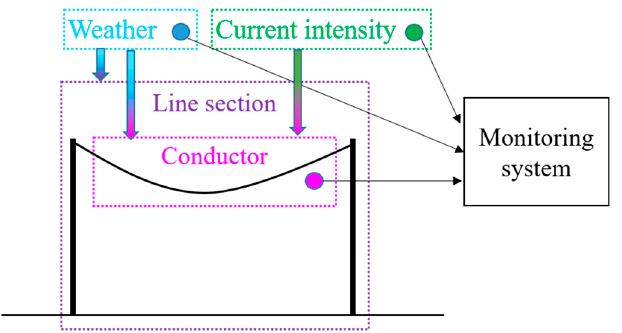
Figure 1. Line section monitoring.